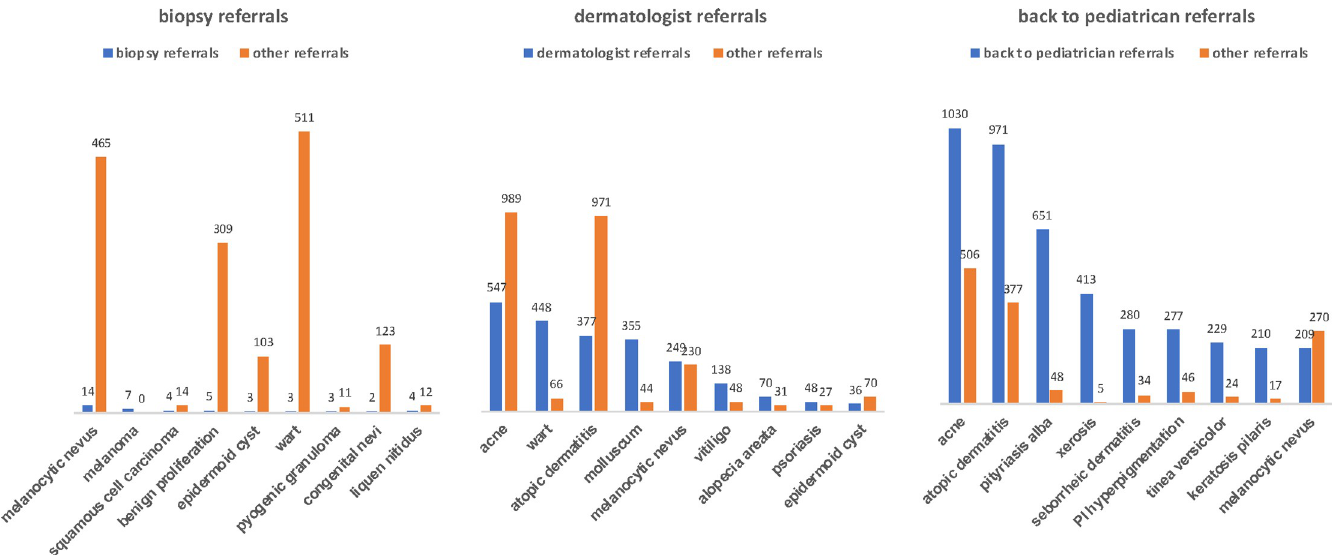
Fig 3. Most frequent lesions sent to biopsy, dermatologists and back to pediatrician in patients 0–19 years old who participated in the Teledermatology Project according to age and sex, from July 2017-July 2018, in the city of S ã o